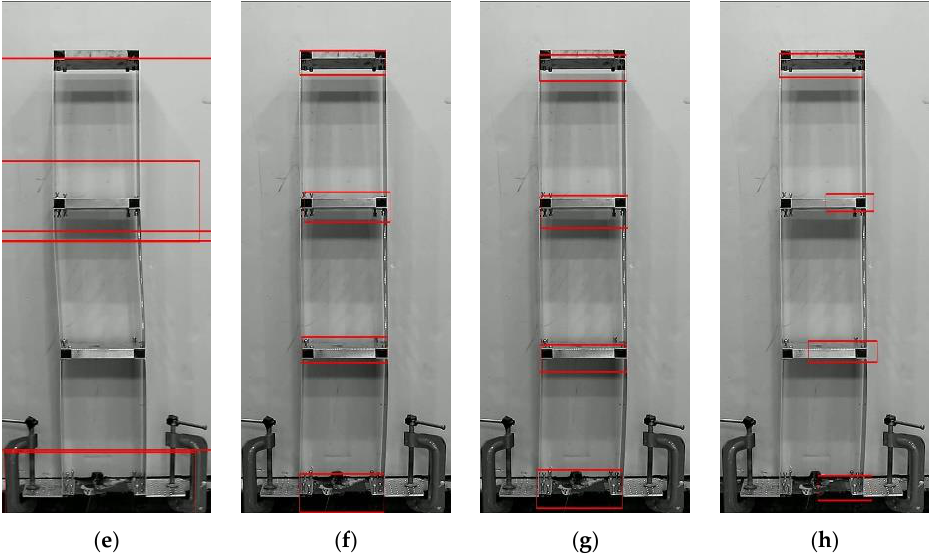
Figure 7. Vision-based displacement measurement: ( a ) region of interest (ROI) at the initial frame, ( b – h ) ROI at the final frame using different tracking algorithms.